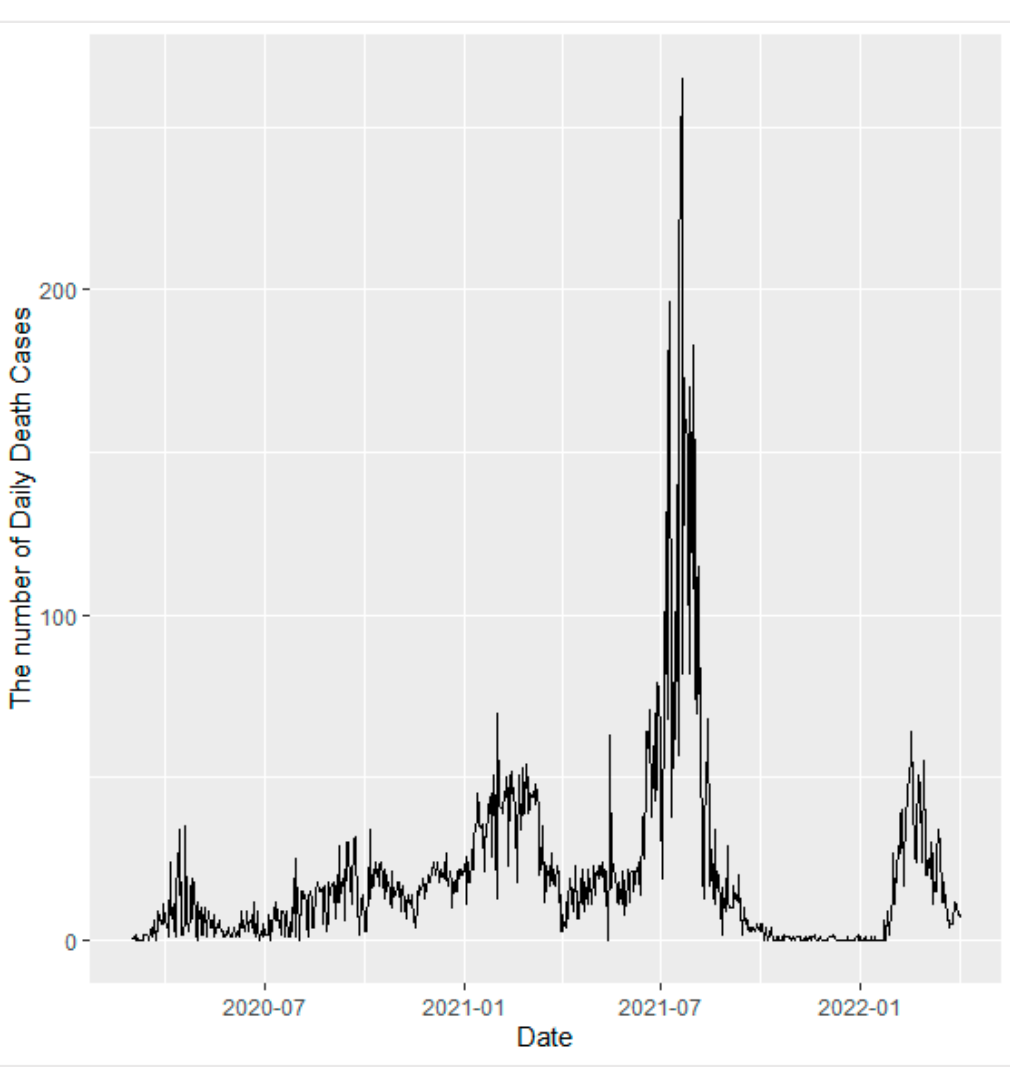
Figure 2. The daily death cases from 2 March 2020 to 3 April 2022, in Jakarta.